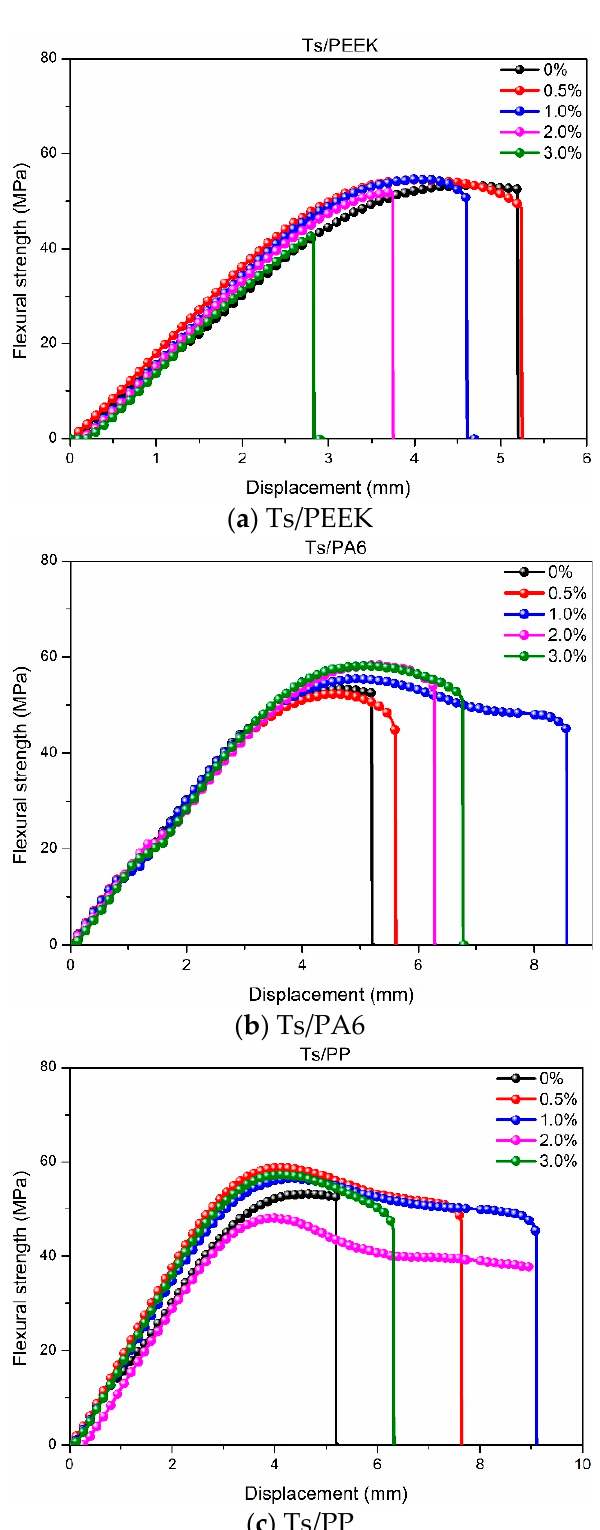
Figure 7. Effects of thermoplastic resin fillers on the flexural strength-displacement curves of Ts resin of ( a ) Ts/PEEK, ( b ) Ts/PA6 and ( c ) Ts/PP.